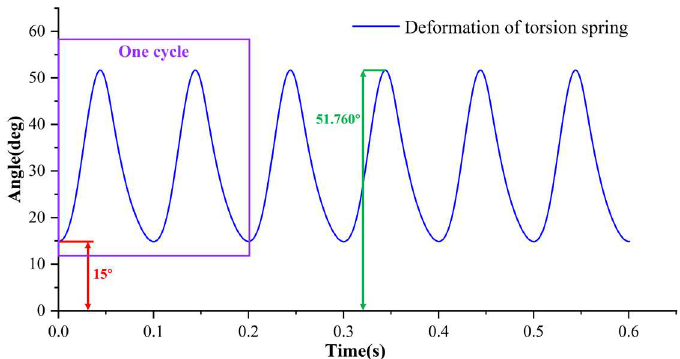
Figure 11. The curve of deformation of the torsion spring.